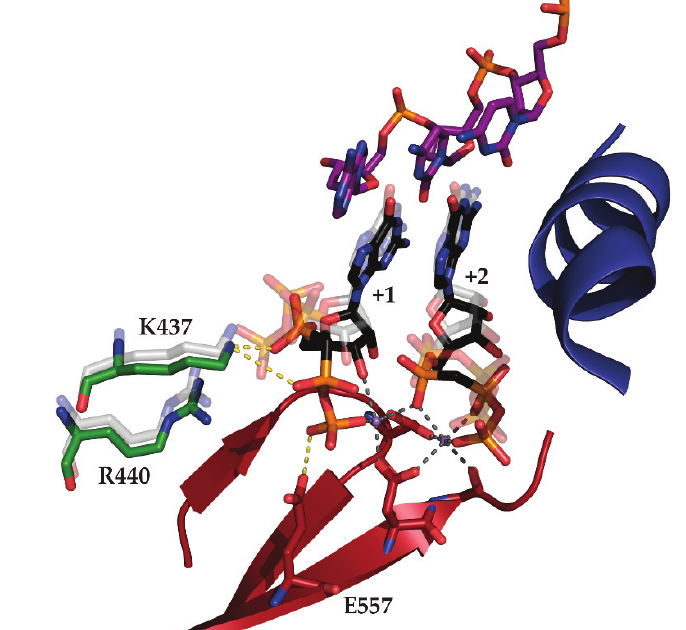
Figure 6. Structural transitions between mini-vRNAP SCI (Accession number 3Q22) and SCII (Accession number 3Q23) complexes required for stabilization of the initiating nucleotide. SCII complex structural motifs required for catalysis, O helix (dark blue) and motifs A and C (dark red), are represented as cartoons. Template strand DNA from (cid:5)1 to +2 is represented as purple sticks. +1 and +2 GMPCPP molecules are represented as black sticks. Catalytic metals are represented as violet spheres. Palm domain residues required for stabilization of +1 NTP phosphate interactions are represented as green sticks. Catalytic aspartates and motif A residue E557 required for stabilization of +1 NTP phosphates are represented as red sticks. Interactions between residues and the catalytic aspartates are represented as dark grey dashes and interactions required for stabilization of +1 NTP phosphates are represented as yellow dashes. SCI residues K437 and R440, along with +1 and +2 GTP, are represented as transparent light grey sticks. Upon transition to the SCII complex, the phosphate residues of the initiating nucleotide break contact with R440 and are re-stabilized by E557 after a large conformational change. This change facilitates the repositioning of the 3'OH within 3.1 Å of the +2 NTP